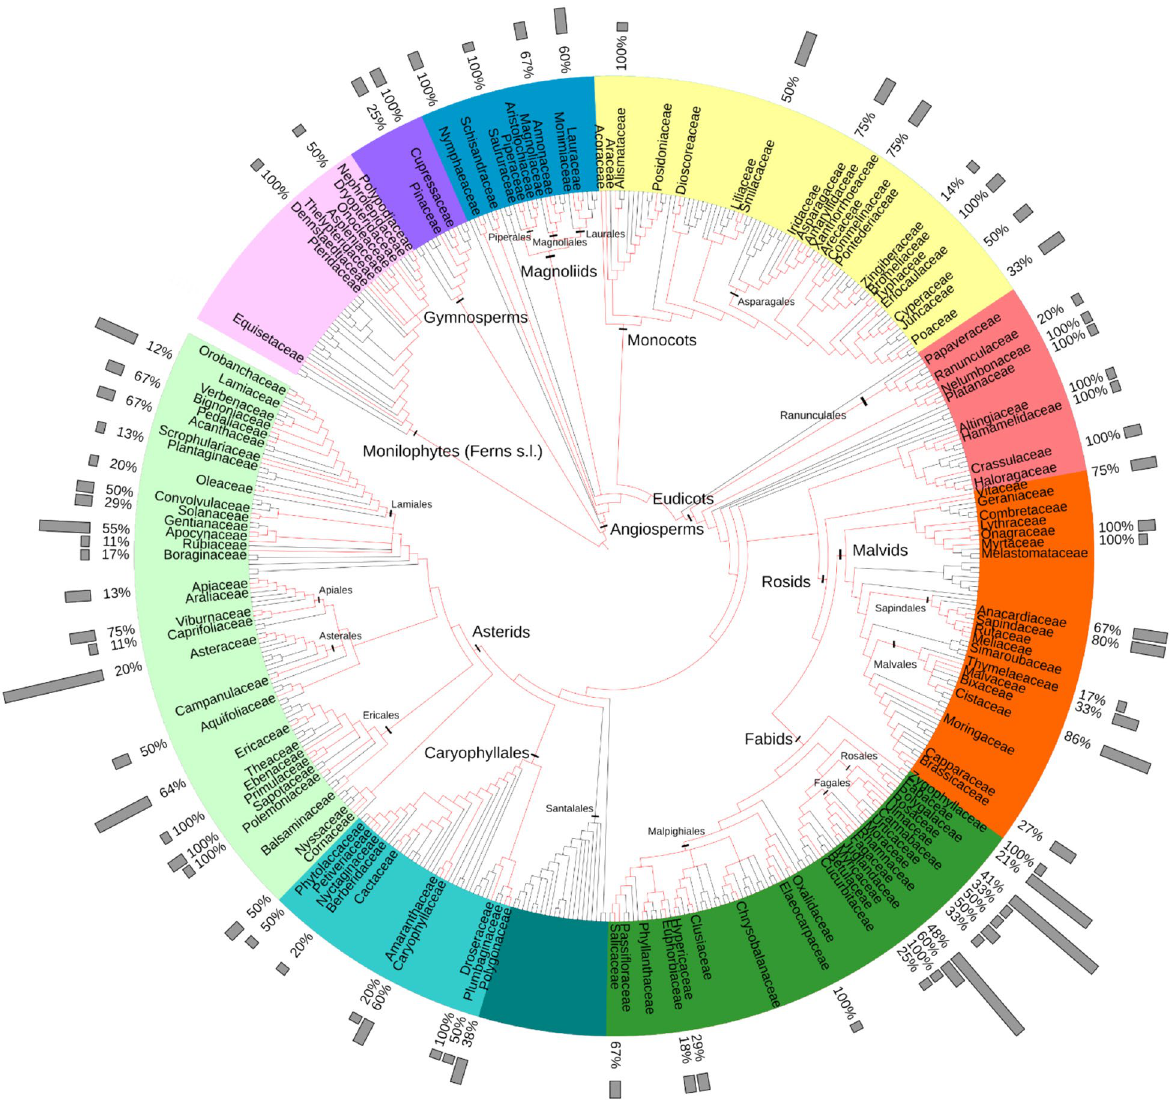
Figure 1. Phylogenetic distribution of plant species tested for SARS-CoV-2 viral entry inhibition. A total of 1867 extracts derived from 660 species (1 Chromista, 27 Fungi, 632 Plantae) across 149 families in the Quave Natural Products Library of plant extracts were screened at a concentration of 20 µg/mL for viral entry inhibition using a wild-type spike (SARS-CoV-2, GeneBank #QHD43416.1) pseudotyped lentivirus model with human embryonic kidney cells expressing human angiotensin converting enzyme 2 (HEK-293T-hACE2). The phylogenetic distribution of plant species demonstrating viral entry inhibition (at ≥ 50% at the screening names are only listed for those genera reported in the present study. Gray bars indicate the percentage of species tested that demonstrated ≥ 50% bioactivity in each family. A high-resolution version of this figure is provided as Supplementary File